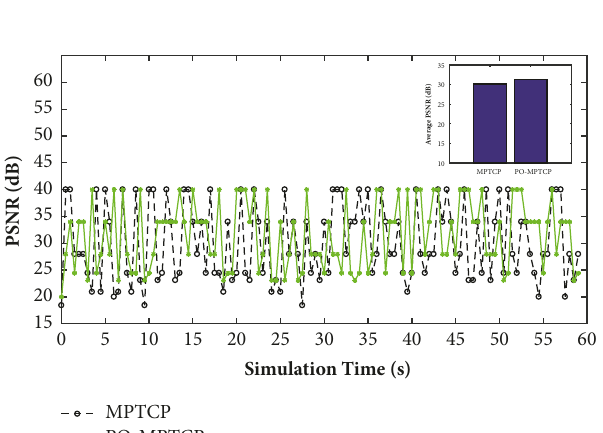
Figure 7: Comparison of jitter.